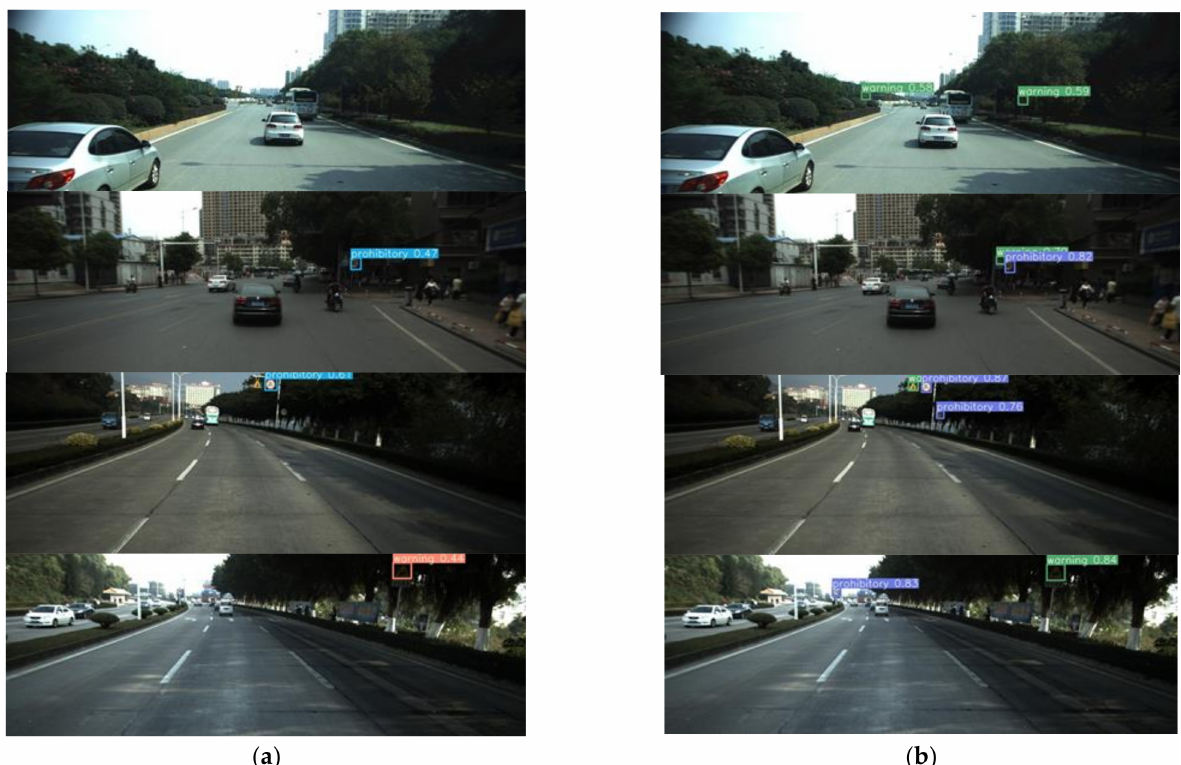
Figure 7. The detection results of YOLOv3 and YOLO-MXANet on the CCTSDB dataset. ( a ) YOLOv3. ( b )